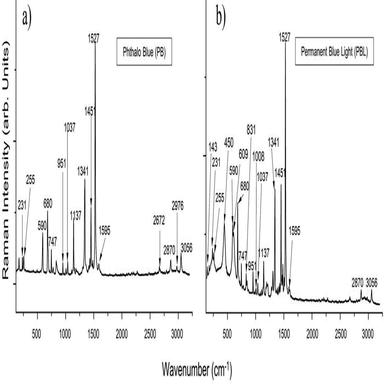
Micro-Raman spectra of a) Phthalo Blue (PB) and b) Permanent Blue Light (PBL) acrylic paints upon excitation at 532 nm.